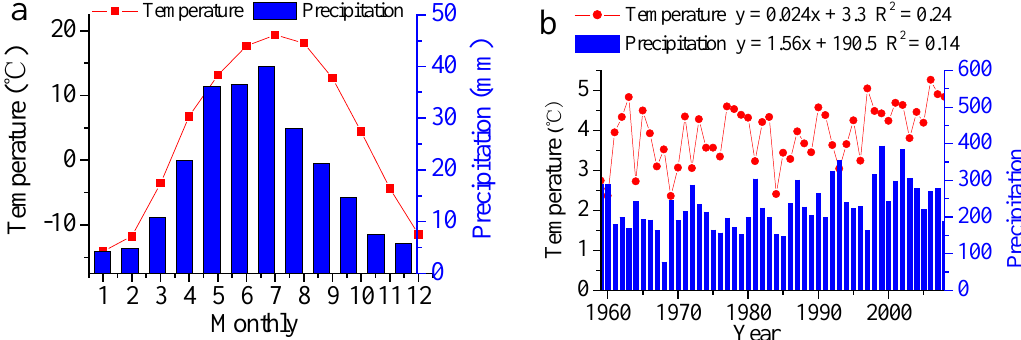
Figure 3. Monthly ( a ) and annual ( b ) changes in mean temperature and total precipitation at the Wenquan meteorological station (1959–2010).